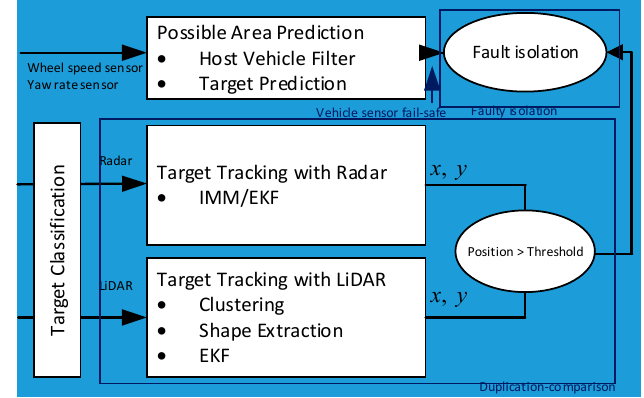
Figure 4. Fail-safe algorithm structure.